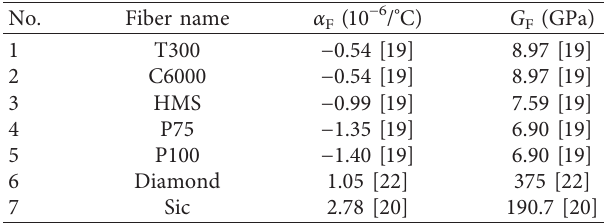
Table 2: Axial shear modulus ( G fibers